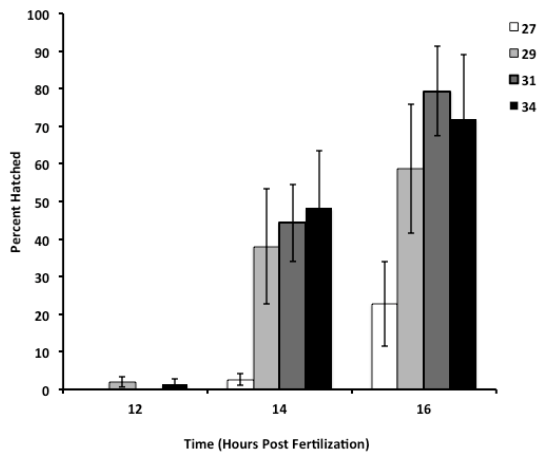
Figure 3. The relationship between percent hatching, salinity, and time in A. cf. solaris . Percent hatching increases with both time and salinity and varied significantly with male/female cross (see Table 1). Each bar represents the mean (±SE) for each of five replicate crosses, measured at three time points (12, 14, and 16 h post-fertilization).